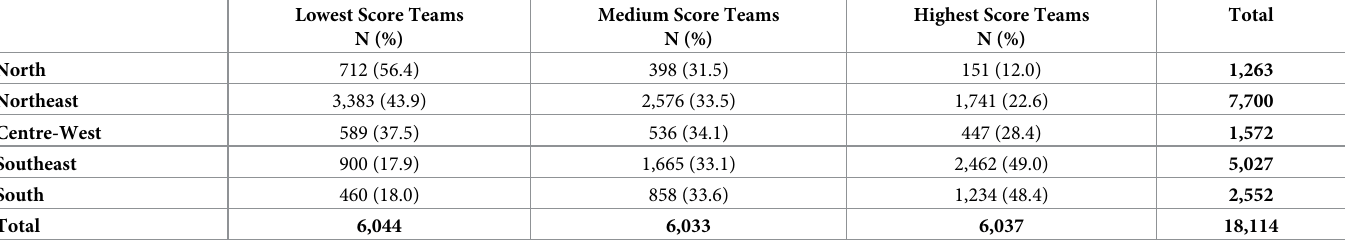
Table 3. Frequency of dental teams with low, medium and high scores according to each Brazilian Geographical Region—North, Northeast, Centre-West, Southeast and South. Brazil,